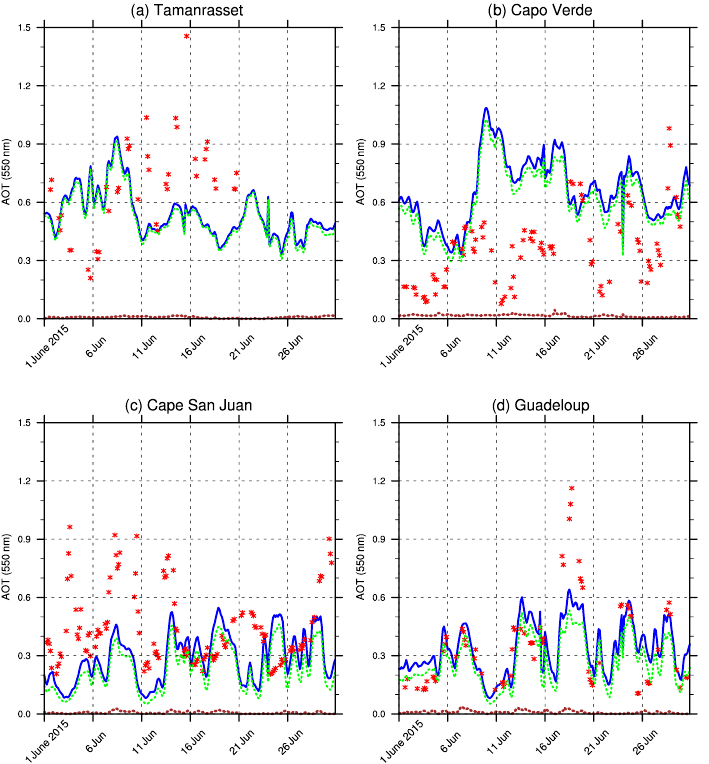
Figure 12. Comparison of 550nm AOT between NGACv2 and four AERONET locations for the month of June 2015. The blue line represents total AOT, the green line is for dust and the brown line is for OC AOT, all from NGACv2. The red asterisk is for AERONET observations at that location. AERONET station locations are marked in Fig. 11a.